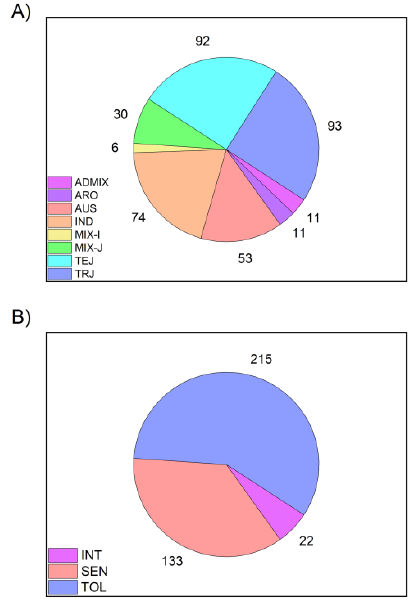
Figure 1. Pie charts of the genetic background composition of the 370 rice accessions used in this study, and the grouping of them into 3 cold tolerance clusters. ( A ) Subpopulation distribution of the 370 accessions. ADMIX: admixes between accessions of the two subspecies INDICA ( aus and indica ) and JAPONICA ( aromatic , temperate japonica , and tropical japonica ); ARO: aromatic ; AUS: aus ; IND: indica ; MIX-I: admixed INDICA ; MIX-J: admixed JAPONICA ; TEJ: temperate japonica ; TRJ: tropical japonica . ( B ) Grouping of the eight subpopulations into 3 cold tolerance clusters. TOL: Cold Tolerant, composed of MIX-J, TEJ, and TRJ; INT: Intermediate Cold Tolerant, composed ADMIX, and ARO; SEN: Cold Sensitive, composed of AUS, IND, and MIX-I (see Figure 2 and Table 1 for